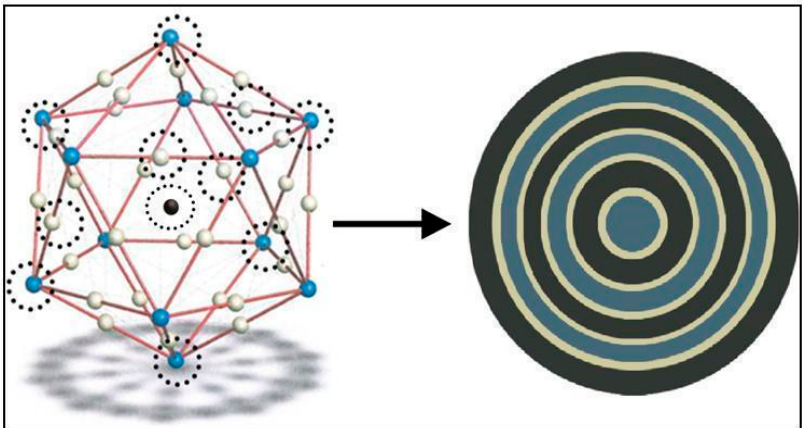
Figure 10. First variation of the corresponding body-centered unit cell transformed to an eleven-phase spherical unit cell (consideration of interphase concept).